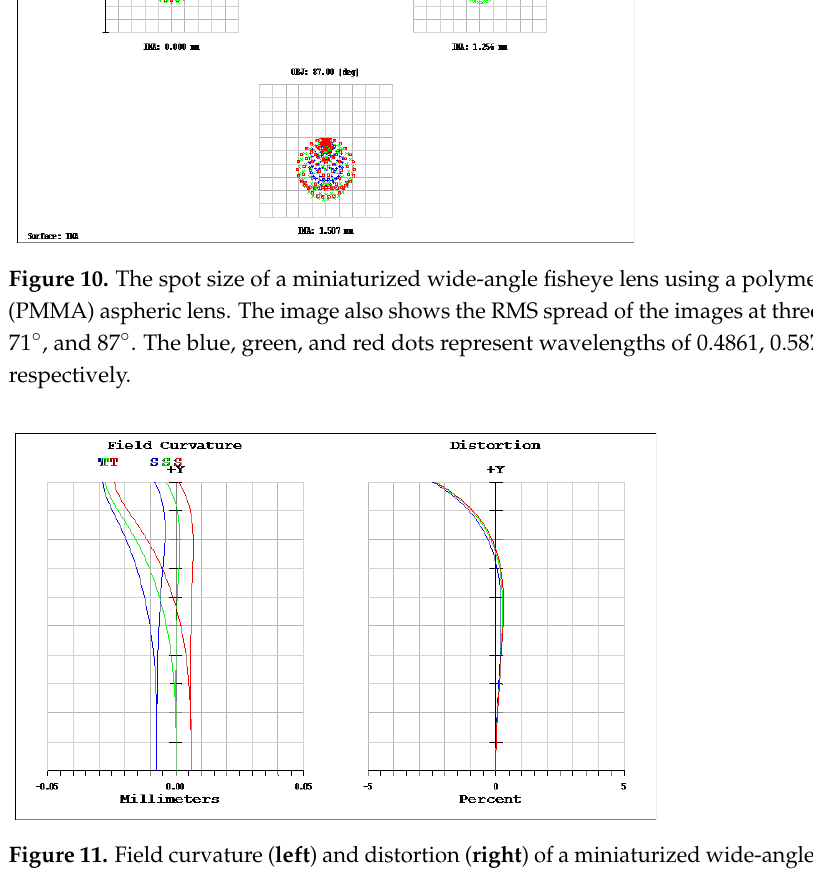
Figure 12. Lateral color of wide-angle fisheye lenses using a polymethyl methacrylate (PMMA) as- pheric lens. The blue, green, and red lines represent the wavelengths of 0.4861, 0.5876, and 0.6563 μm.